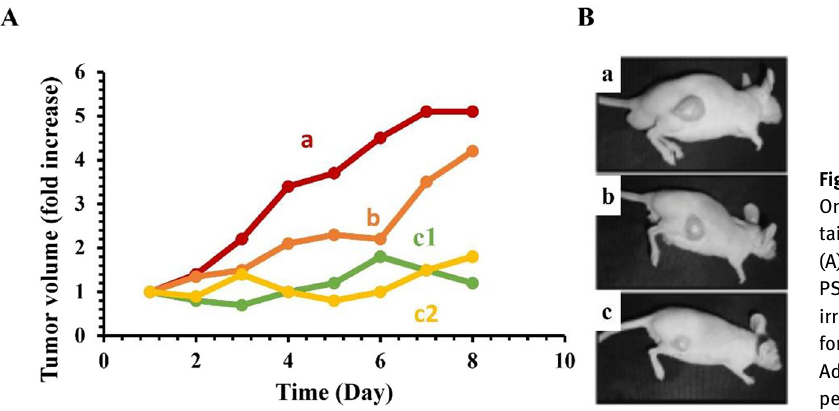
Figure 35: Tumor growth curve in nude mice. On day 0, PS formulations were injected via